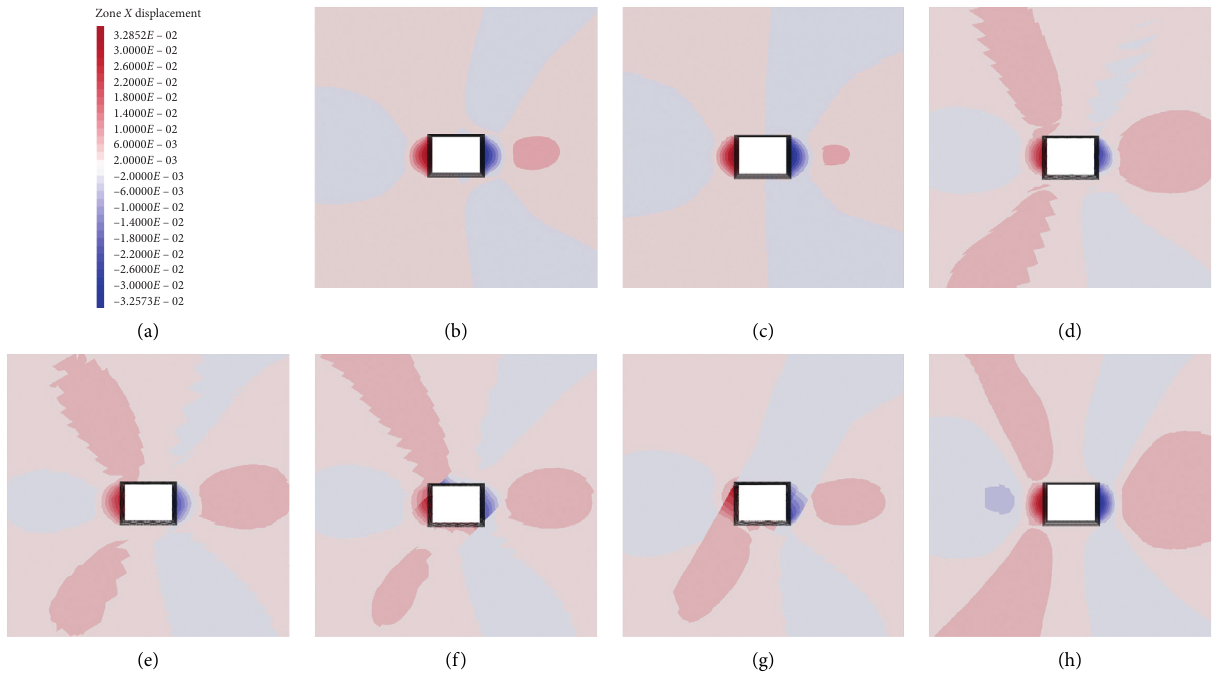
Figure 8: Horizontal displacement nephogram. (a) Displacement legend. (b) No structural plane. (c) Horizontal structural plane. (d) Structural plane with 15 ° . (e) Structural plane with 30 ° . (f) Structural plane with 45 ° . (g) Structural plane with 60 ° . (h) Vertical structural